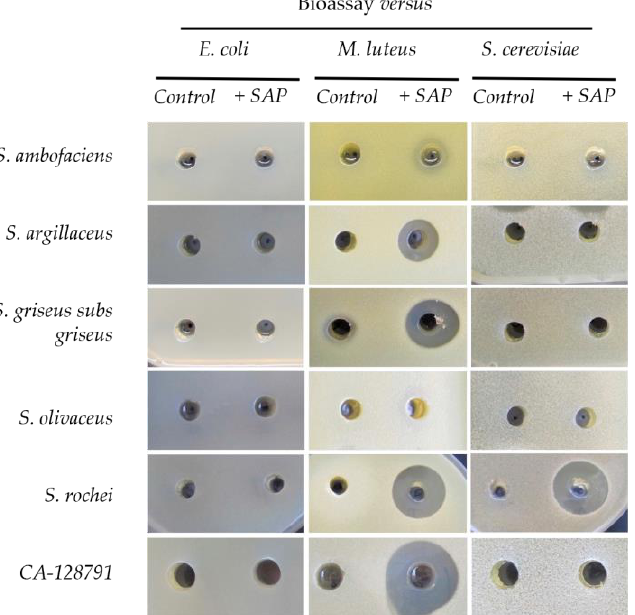
Figure 6 . Bioactivity of 100  L of the extracts of the indicated Streptomyces strains in the absence Figure 6. Bioactivity of 100 µ L of the extracts of the indicated Streptomyces strains in the absence (Control) or the presence of sap (+SAP) against E. coli , M. luteus , and S . cerevisiae . All the experiments (Control) or the presence of sap (+SAP) against E. coli , M. luteus , and S. cerevisiae . All the experiments were performed four times with three biological replicates each. were performed four times with three biological replicates